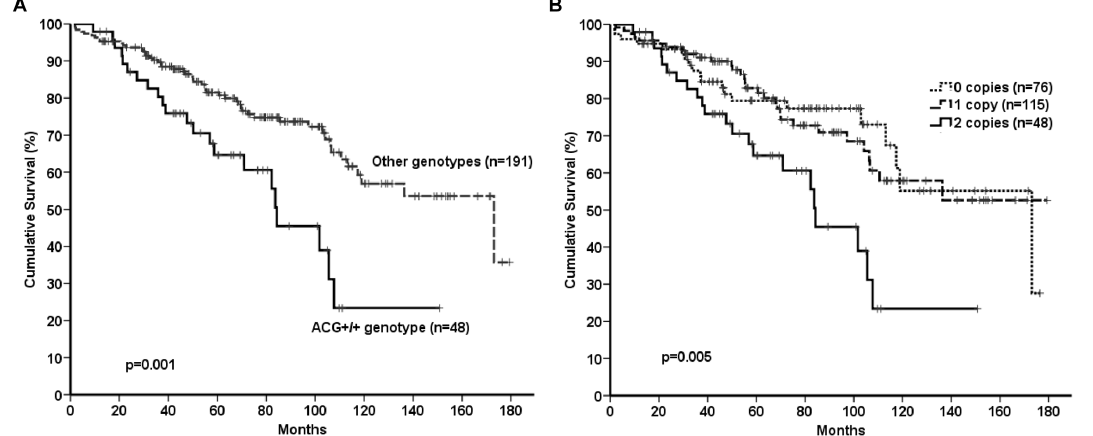
Figure 1. Association of VEGFA genotypes and OS of 239 CLL patients. Kaplan-Maier curves according to: (A) a recessive comparison of rs699947/rs833061/rs2010963 ACG + / + genotype and, (B) number of copies of ACG haplotype.